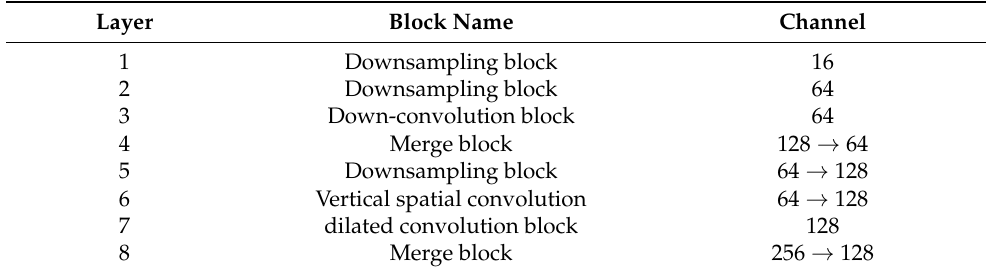
Table 1. The specific structures of the modules used in this decoding branch.